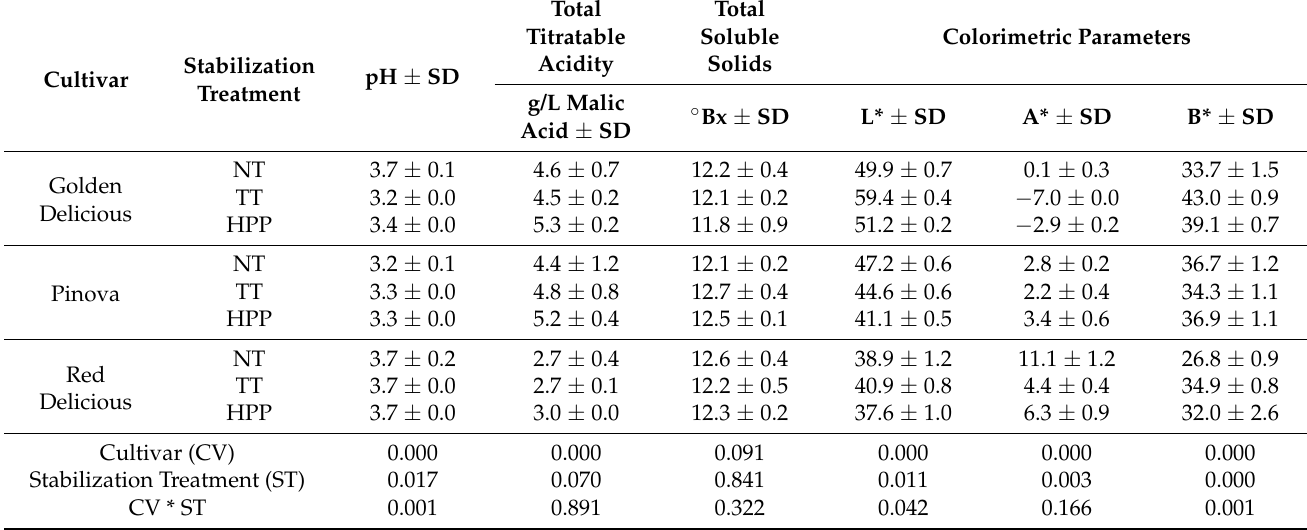
Table 1. Influence of cultivar and stabilization treatment on physicochemical parameters of apple juices.